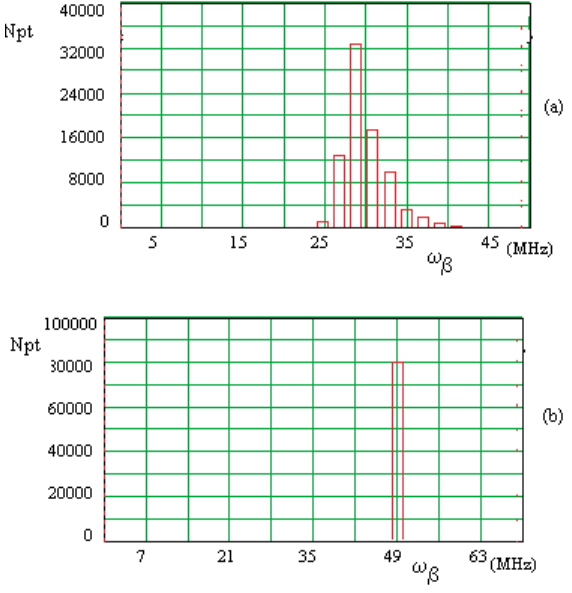
FIG. 2. (Color) Beam betatron frequency distribution: (a) case for s (cid:5) s 0 (cid:2) 0.55 and (b) case for s (cid:5) s 0 (cid:2) 0.83 . Npt is the particle